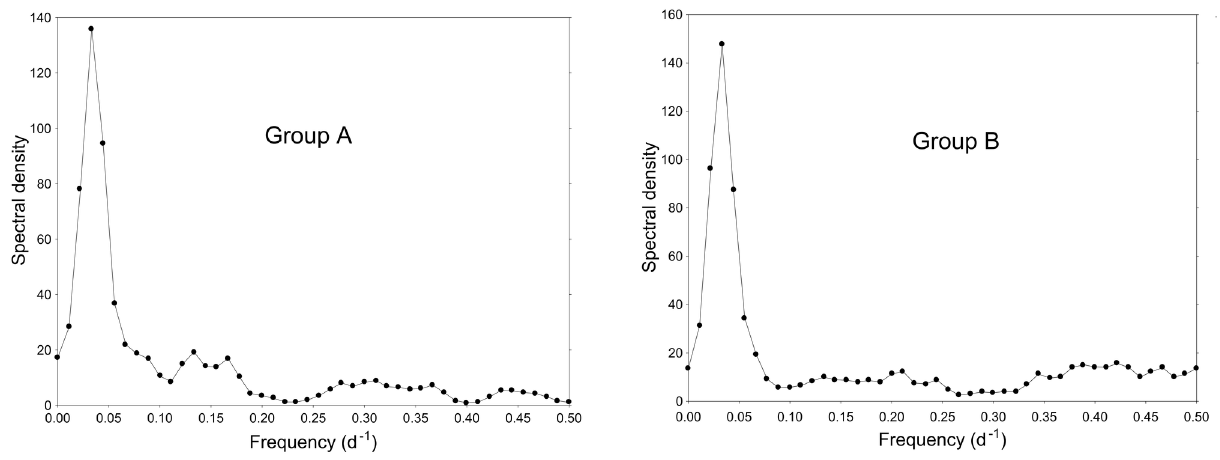
Figure 7. Spectral density plots for the three-month time series of daily molt frequencies (experiment 2). Males and females pooled. Group A (artificial cycle in phase with the natural lunar cycle) with peak at 0.033 d -1 and group B (artificial cycle phase-shifted by half the lunar period) with peak at 0.033 d -1 .